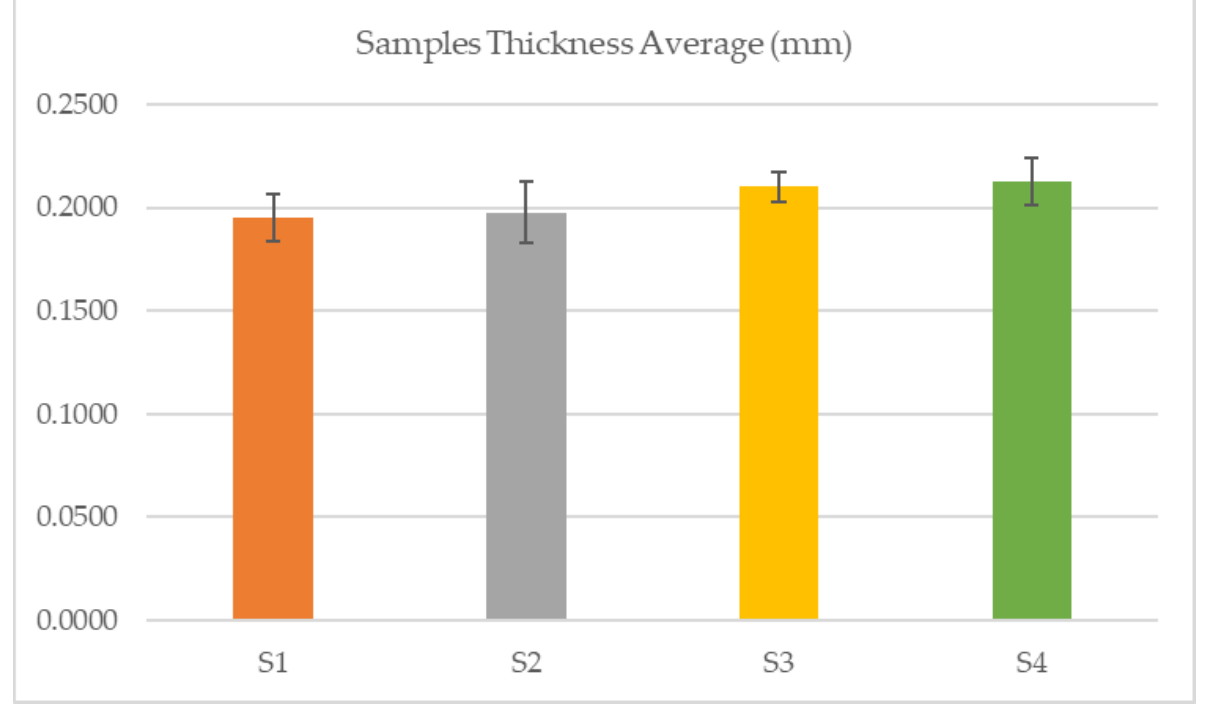
Figure 2. The average thickness of the samples (mm).